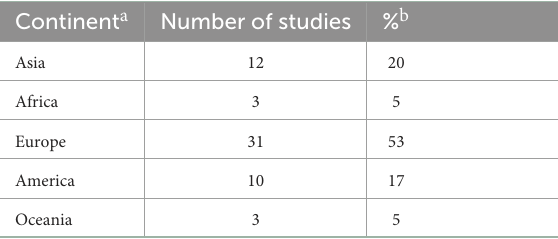
TABLE 1 Number of studies per continent. Continent a Number of studies %